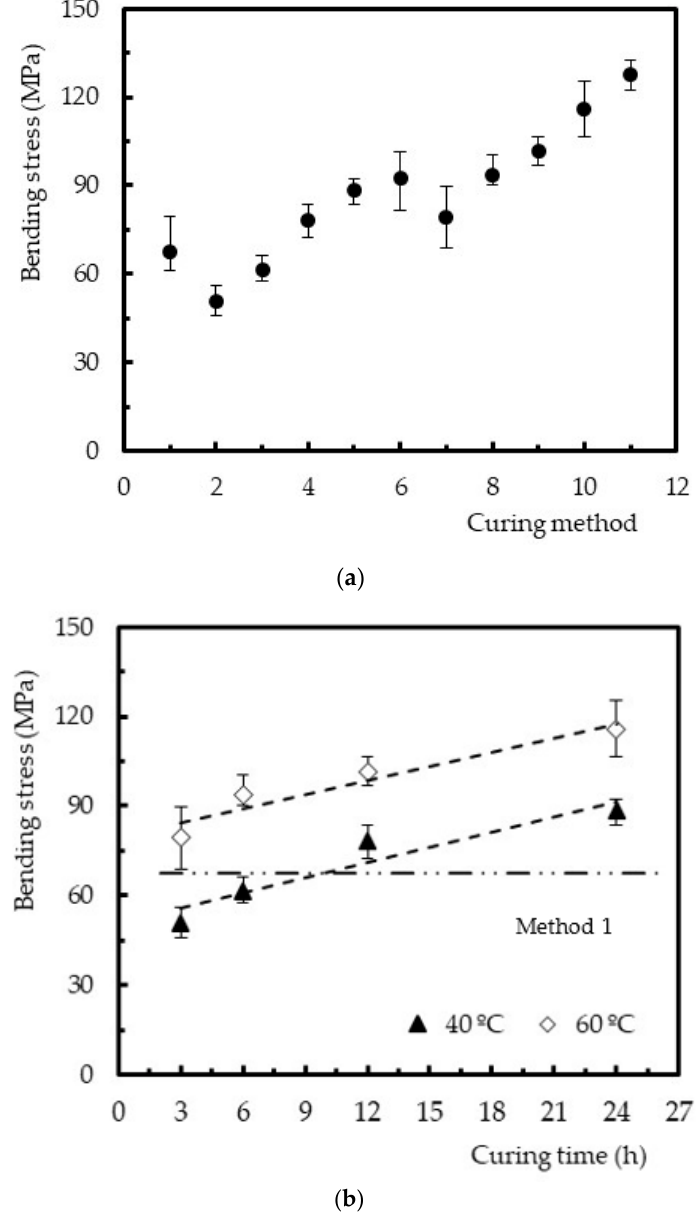
Figure 7. ( a ) Effect of the curing parameters on the bending stress and ( b ) effect of the post-cure on the Figure 7. ( a ) E ff ect of the curing parameters on the bending stress and ( b ) e ff ect of the post-cure on the bending stress. bending